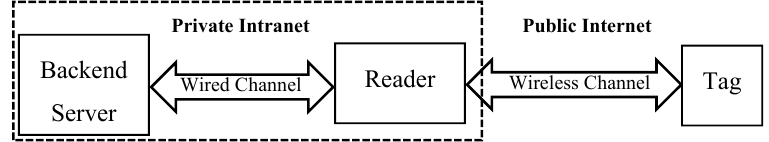
Figure 3. Communication channels in a typical RFID system.